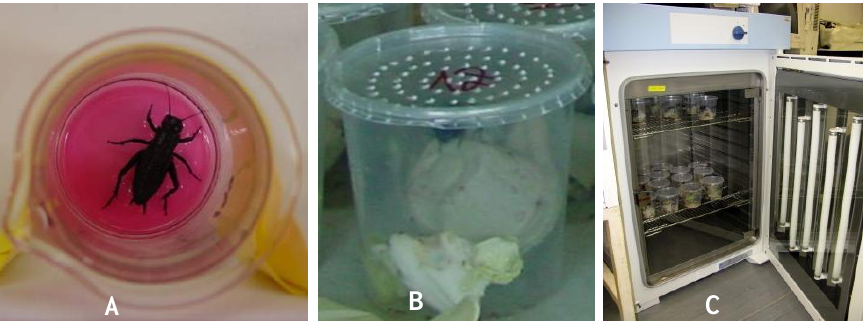
Figure 1. ( A ) Infection of a cricket by dipping into virus suspension. ( B ) Individual beaker with a cricket used in the infection studies. ( C ) Beakers were kept in a thermoregulated incubator with